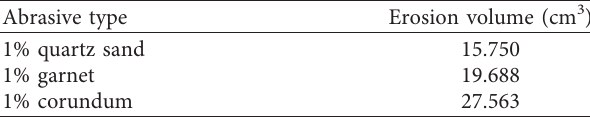
Table 5: Effect of abrasive types on the erosion performance. Abrasive